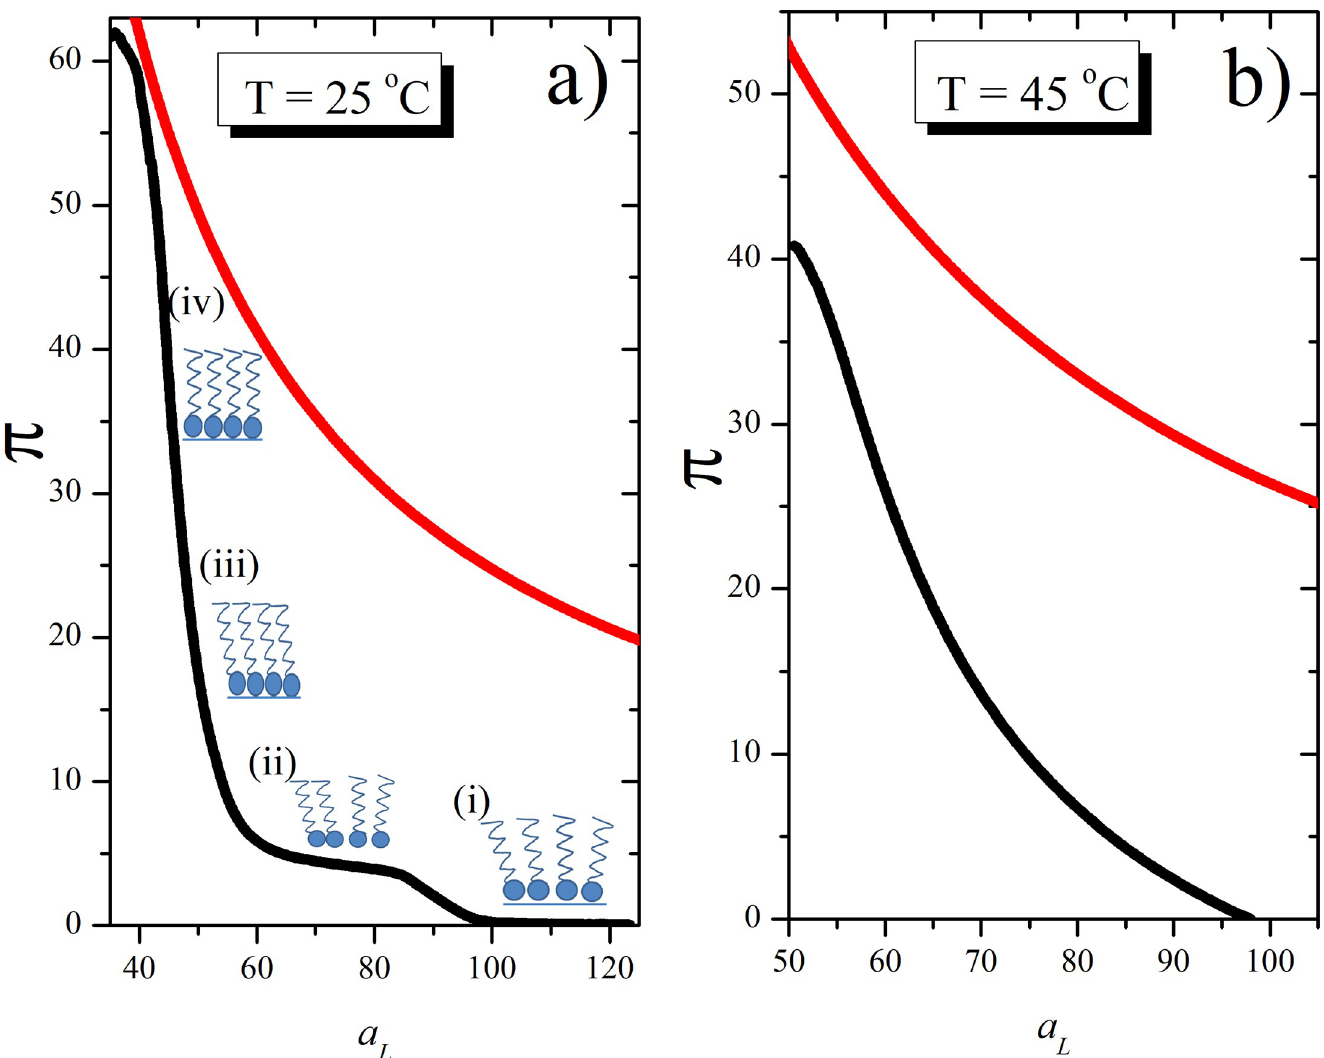
Fig 1. Surface pressure versus area per molecule for an ideal gas model. Experimental (black line) and calculated (red line) π /A per lipid curves for DPPC considering the lipid monolayer as an ideal gas dispersed on an (inert) water surface, according to equation p ¼ RT per lipid were taken from bibliography and surface pressure calculated by means of the ideal gas equation.